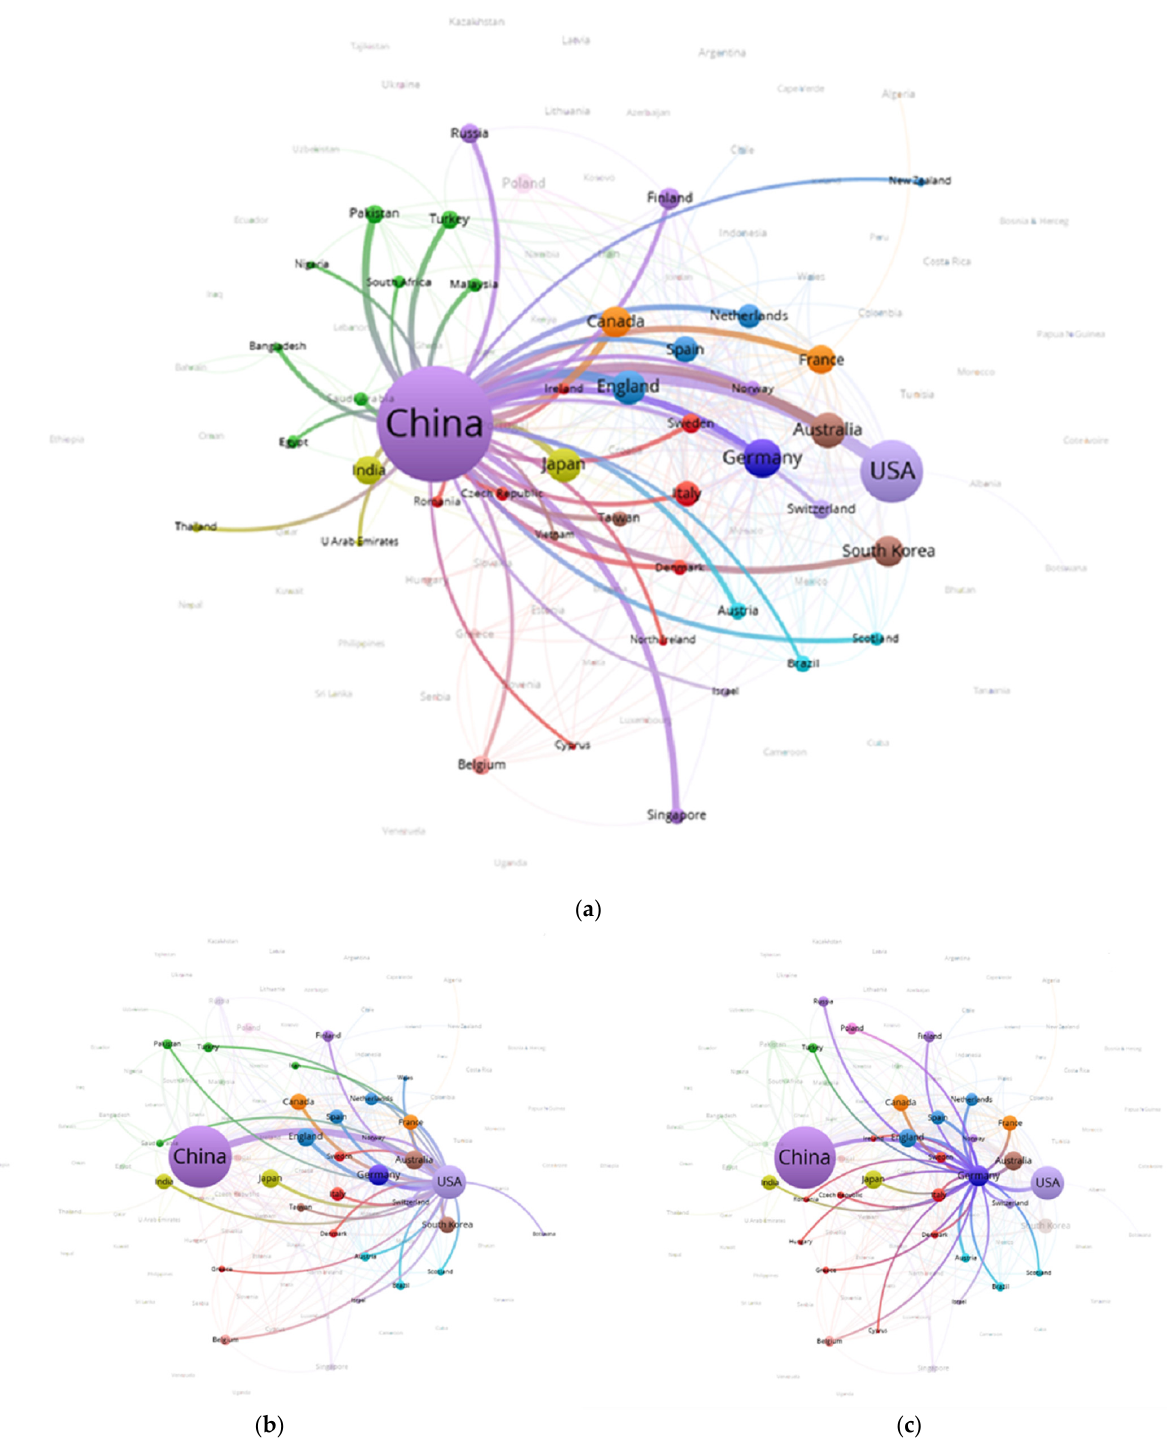
Figure 5. National cooperation networks (( a ) China; ( b ) USA; ( c ) Germany).